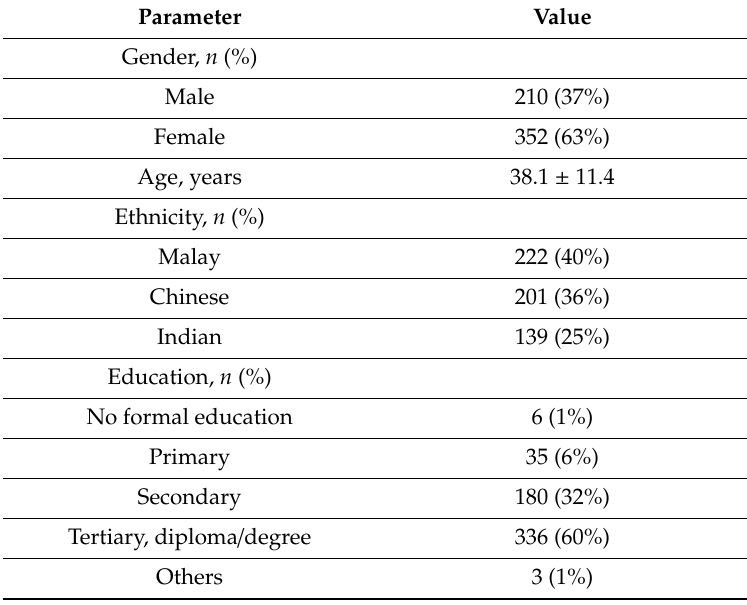
Table 1. Characteristics of Malaysia Lipid Study (MLS) study participants ( n =